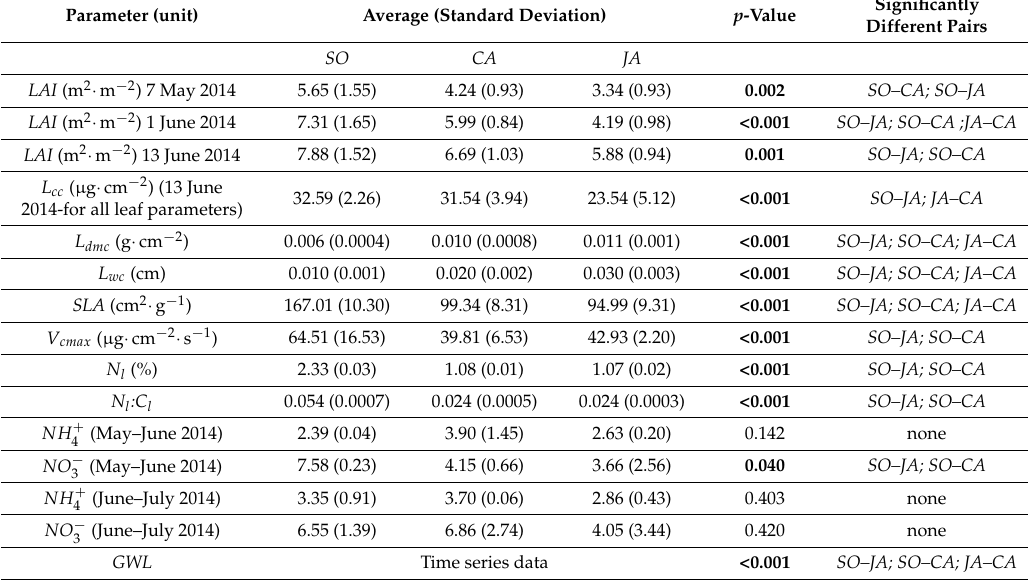
Table 2. One-way ANOVA tests results (with 5% level of significance) for leaf and canopy parameters, soil-available NH ` and NO ´ and groundwater levels ( GWL ). Bold p -values denote significant 3 4 differences (see Figures 5, 6 and 9; and Sections 4.2 and 4.4 for detailed descriptions). Parameter